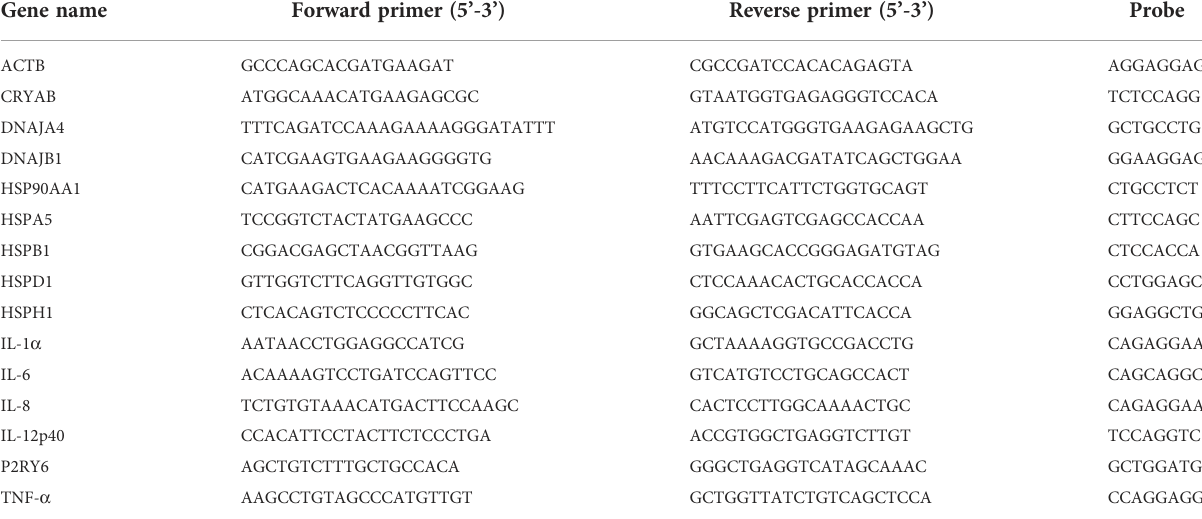
TABLE 3 Overview of primer/probe combinations used for